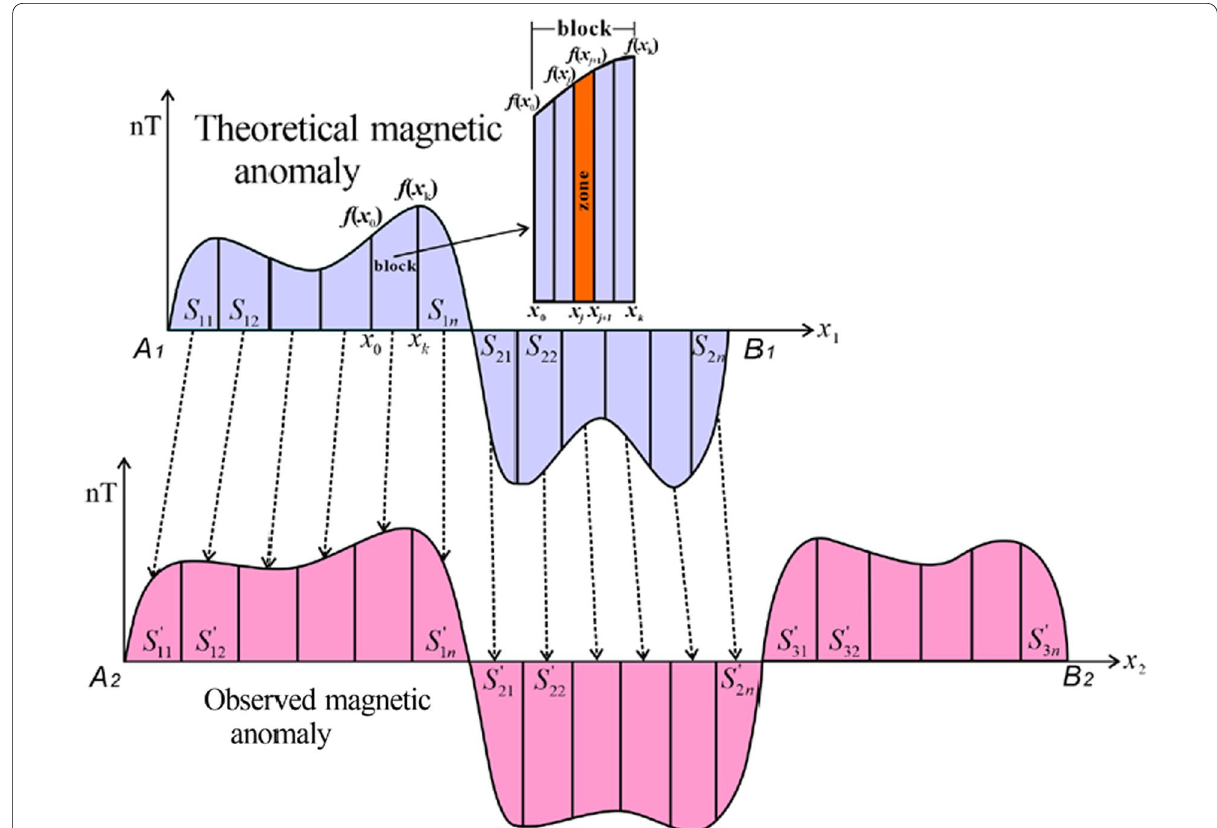
Fig. 1 The diagram of subdivision of the synthetic and observed marine magnetic